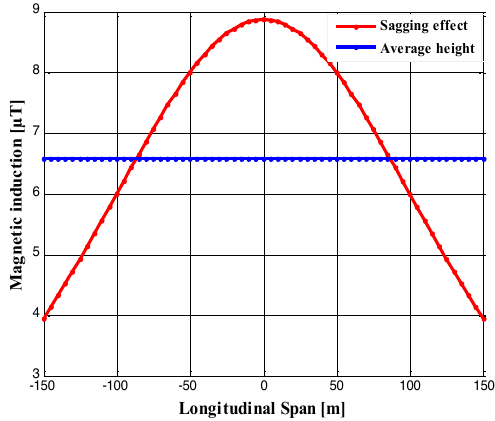
Figure 13: Longitudinal magnetic induction profile at 1 m above ground